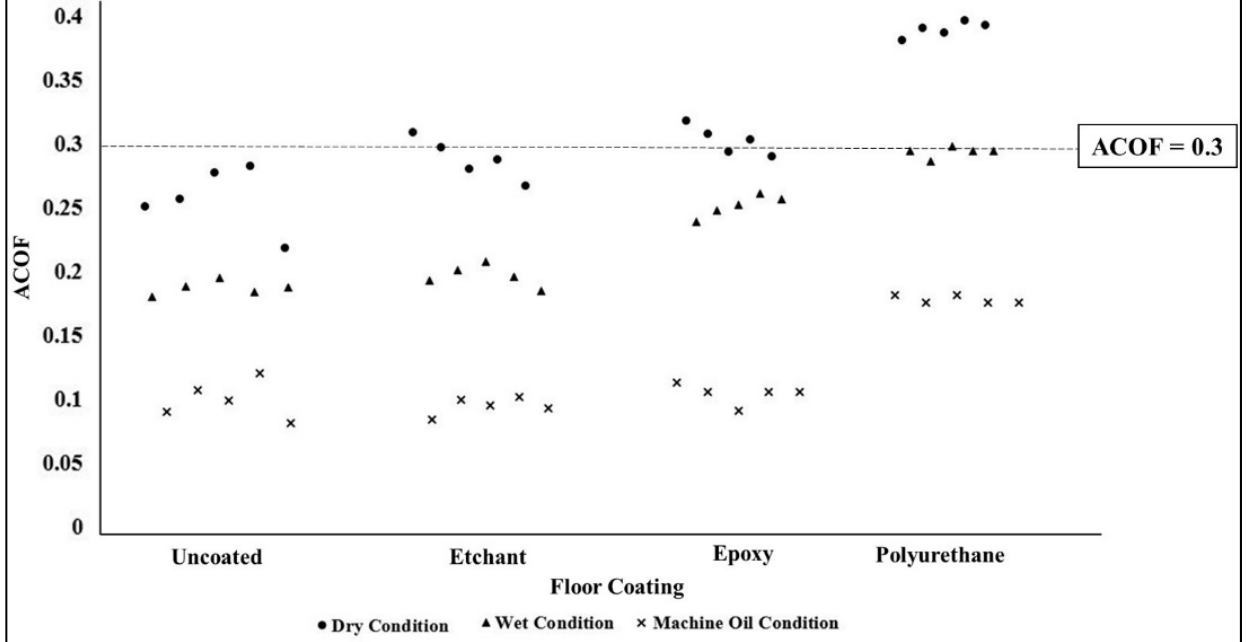
Figure 14. Summary of the slip testing results across each floor coating and the considered shoes.